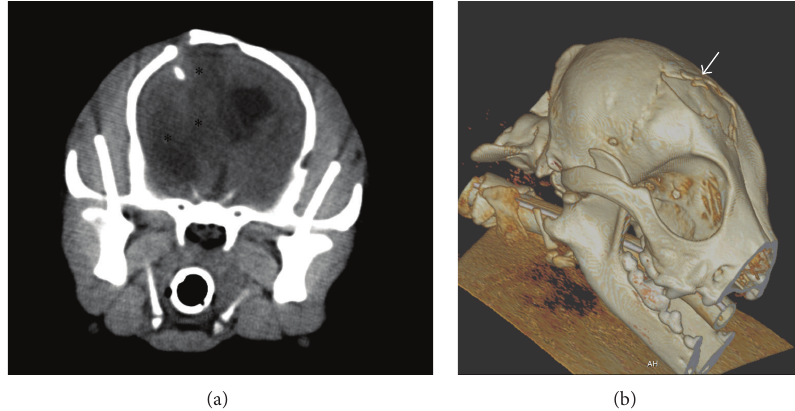
Figure 3: Preoperative, precontrast computed tomography (CT) images of the head. (a) Image in a soft tissue window at the level of mandibular rami. There is midline shift toward the left caused by a large hypodensity in the right cerebrum (asterisks), a calvarial defect, and a mineral fragment within the brain parenchyma. (b) Three-dimensional CT reconstruction of the skull in a bone window. Note the smoothly scalloped edges of the elevated bone flap (arrow) and calvarial defect as well as the size discrepancy between the